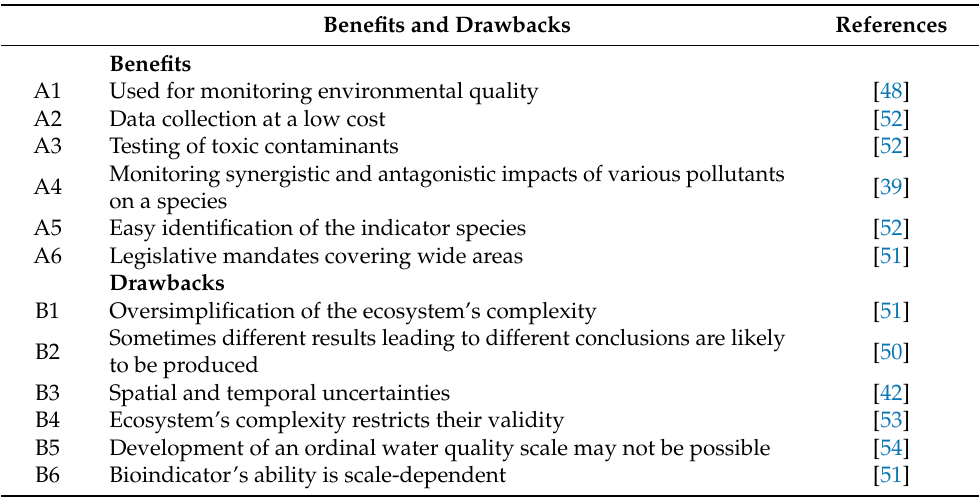
Table 2. Bioindicator species: benefits and drawbacks from their use in water quality studies. Benefits and